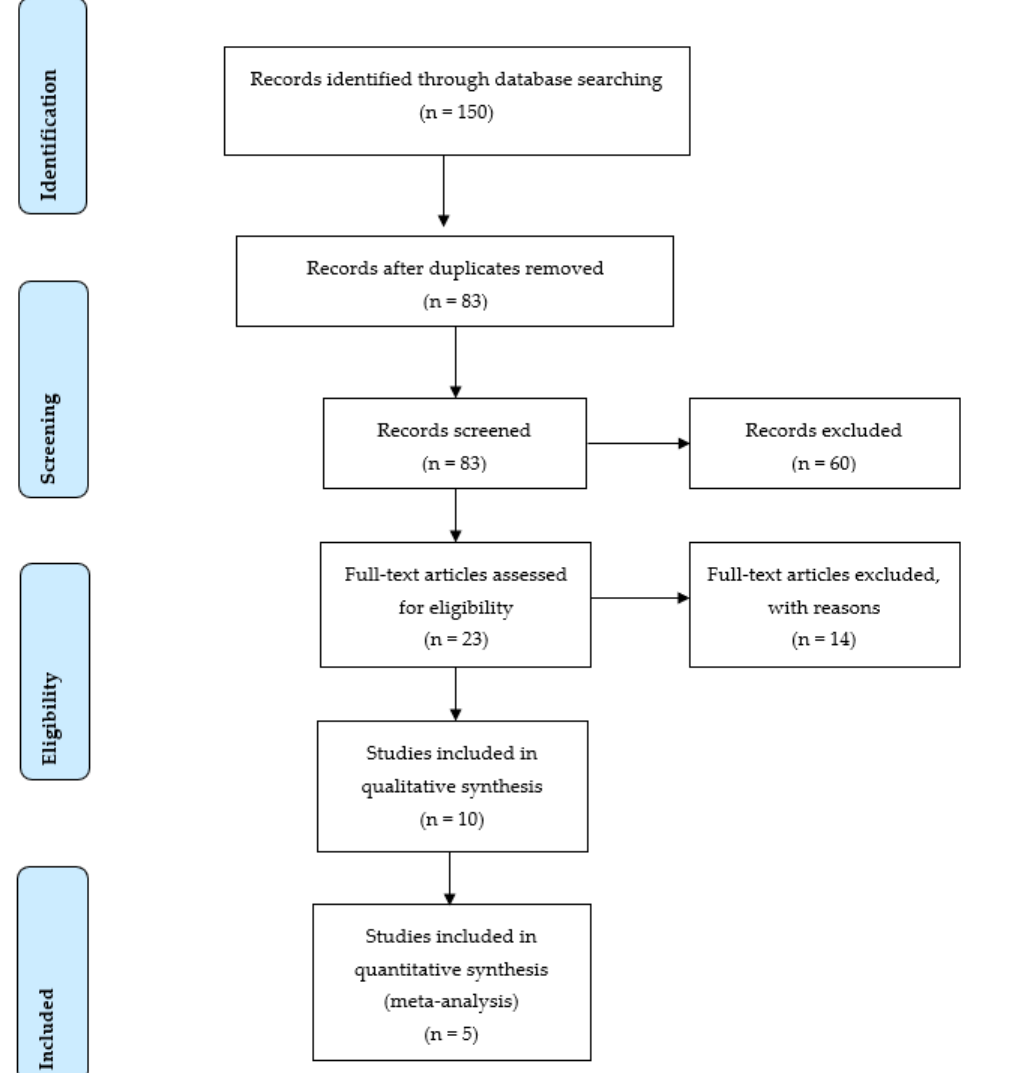
Figure 1. PRISMA Flow chart of search and study selection. Seven studies reported the meniscal tear percentage from the total sample (QTA = 50.03%, HTA = 43.27% and PTA = 60.54%) [14,15,41–43,45,47]. The time between diagnosis and surgery was reported in seven articles (QTA = 12.72 ± 7.01 months; HTA = 10.78 ± 6.29 months; PTA = 16.48 ± 10.96 months) [14,41,43,45,47–49]. The athletic status was only